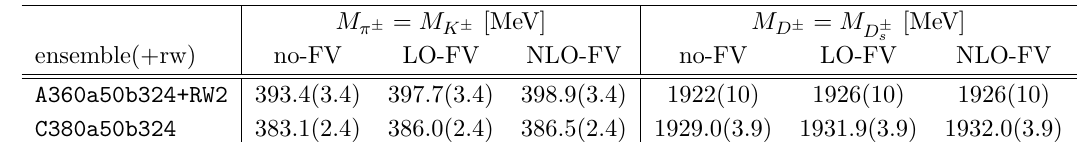
Table 9 . For the two ensemble with α R ' 0 . 04 and tuned values of the quark masses: π ± and D masses calculated with no subtraction of the structure-independent finite-volume corrections (no-FV), with the subtraction of only the 1 /L finite-volume correction (LO-FV), with the subtraction of the 1 /L and 1 /L 2 finite-volume corrections (NLO-FV). The 1 /L 2 finite volume correction produces a 0.3% shift on the π ± mass on the smaller volume, and a 0.1% shift on the π ± mass on the larger volume. Values in MeV are obtained by using the reference value (8 t 0 ) 1 / 2 = 0 . 415 fm